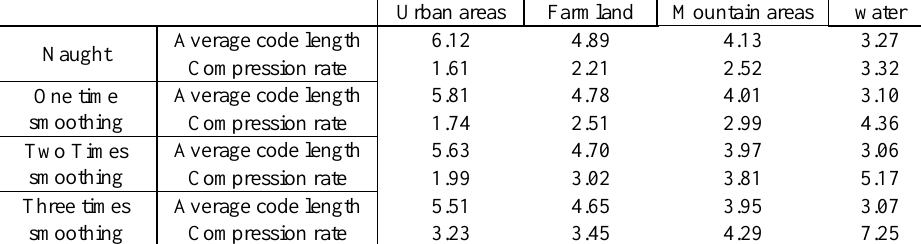
Table 5. Unidirection differential coding of different